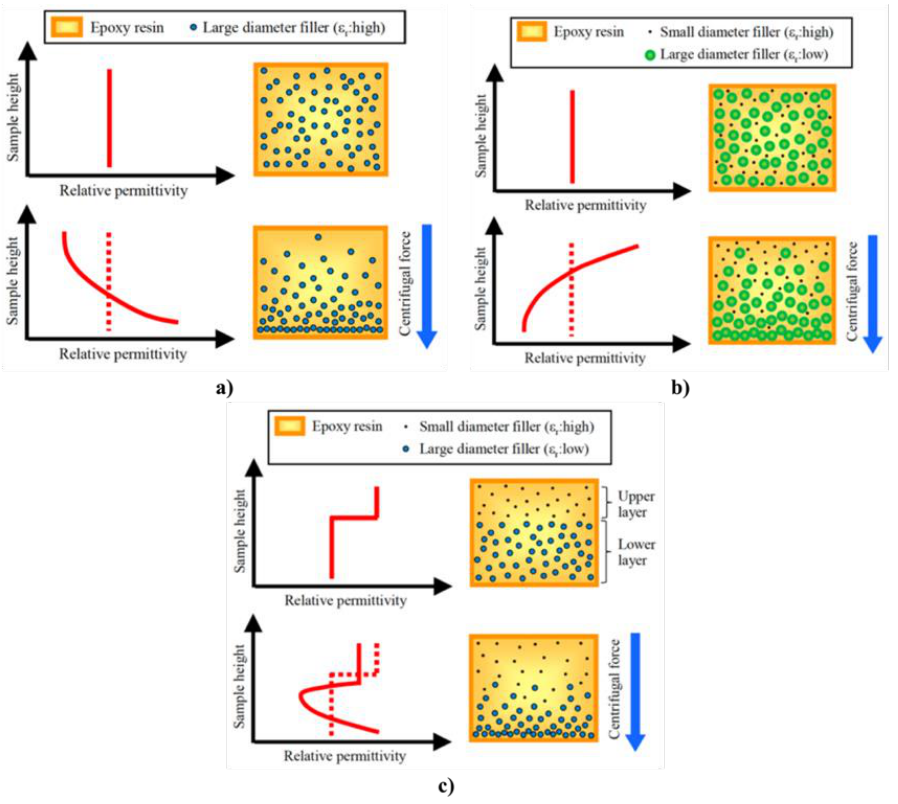
Figure 45. FGM Fabrication with a permittivity gradient: ( a ) GHP-FGM, ( b ) GLP-FGM, and ( c ) U-FGM. © 2021 IEEE. Reprinted, with permission, from [117].